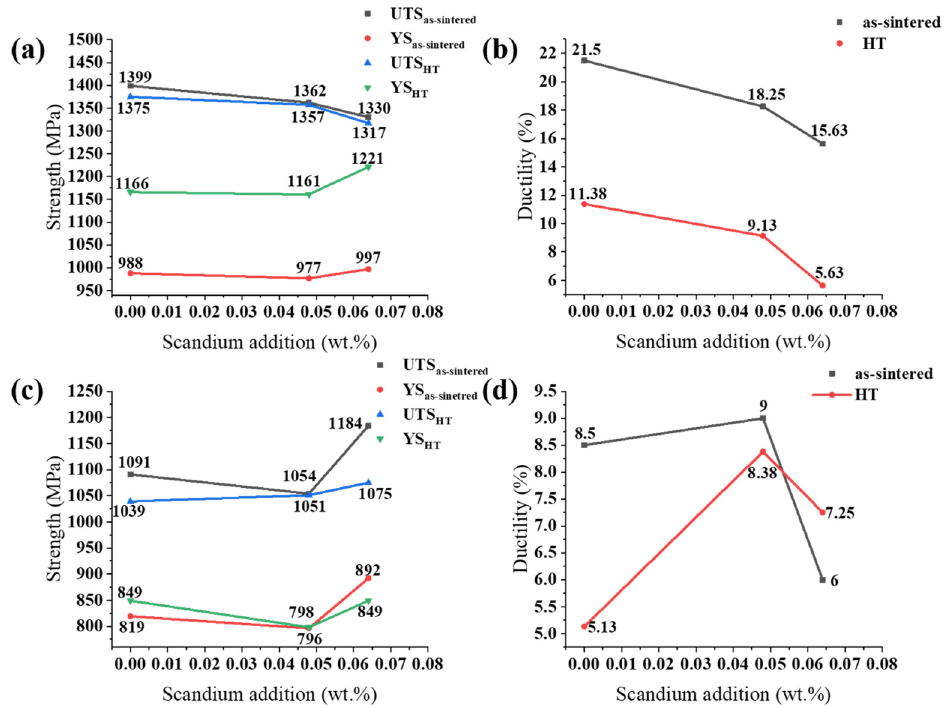
Figure 16. Tensile properties at 25 °C and 750 °C of Sc-doped RR1000 under di ff erent conditions: ( a , b ) 25 °C, ( c , d ) 750 °C.